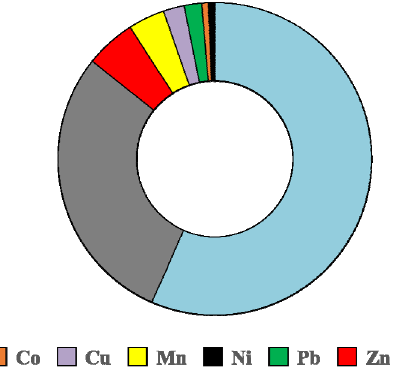
Figure 3. Percentage distribution of metals in the PM 10 fraction.